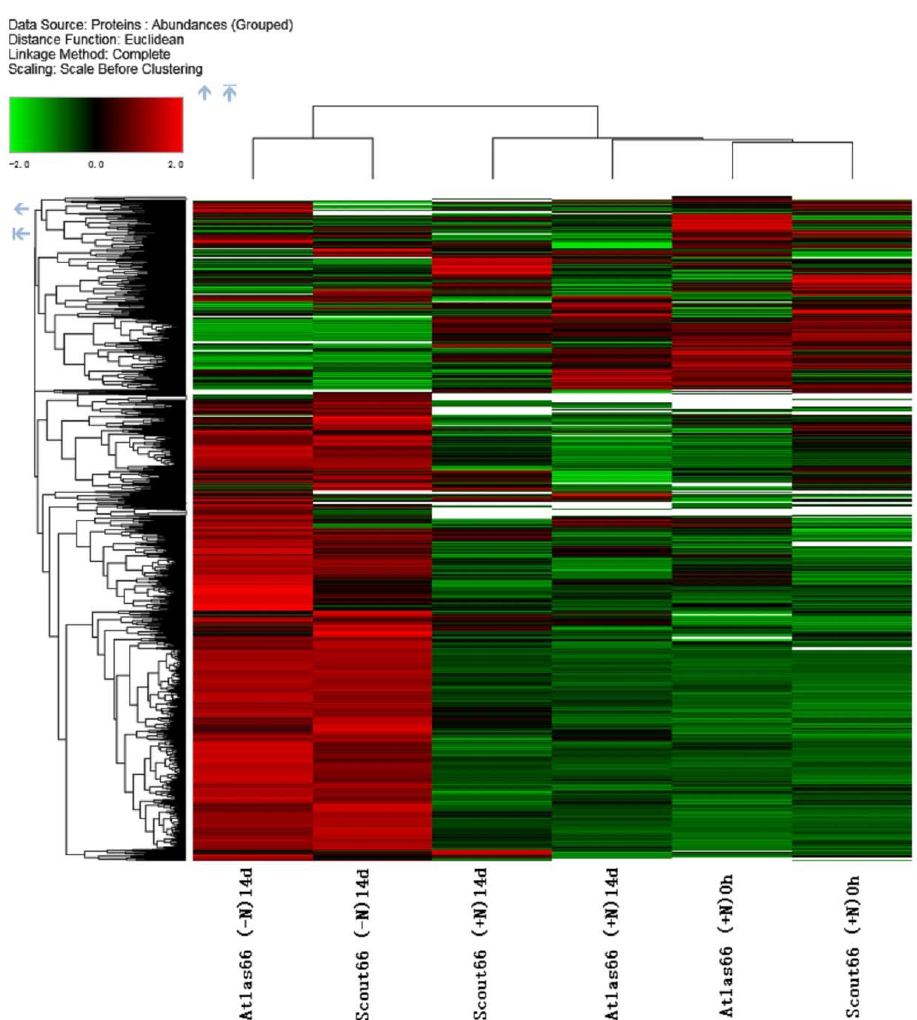
Figure 8. The hierarchical cluster analysis of protein abundance among sample groups in leaves of Atlas 66 and Scout 66. Columns represent the average of each treatment combination and rows indicate abundance of proteins. The relative abundance of proteins is indicated from low to high, marked as from green to